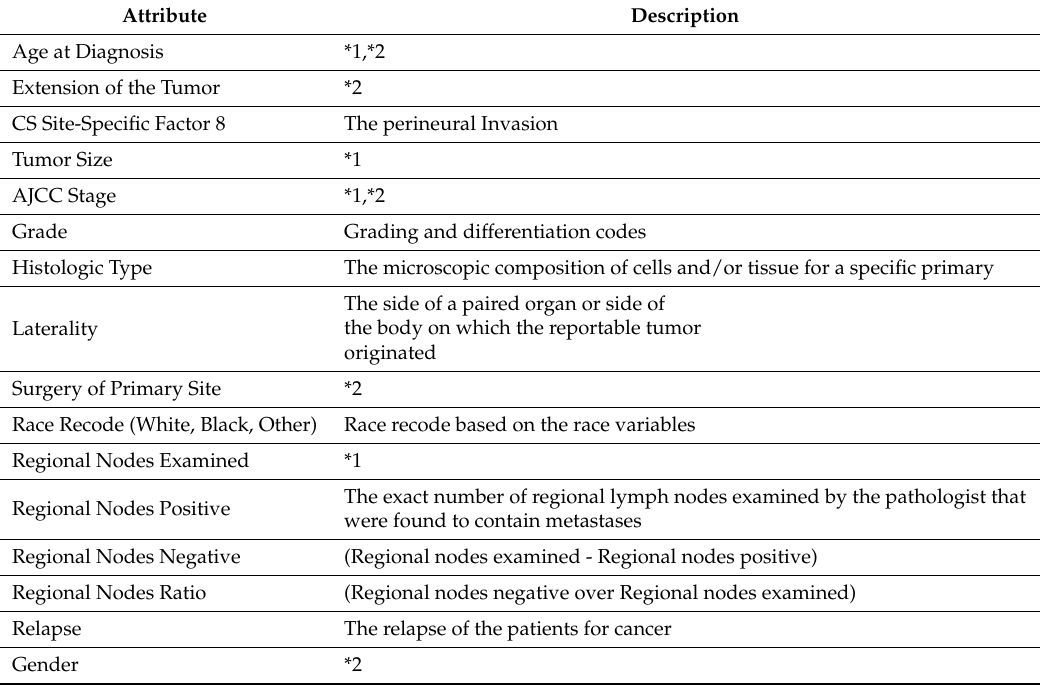
Table 6. Attributes selected by an expert